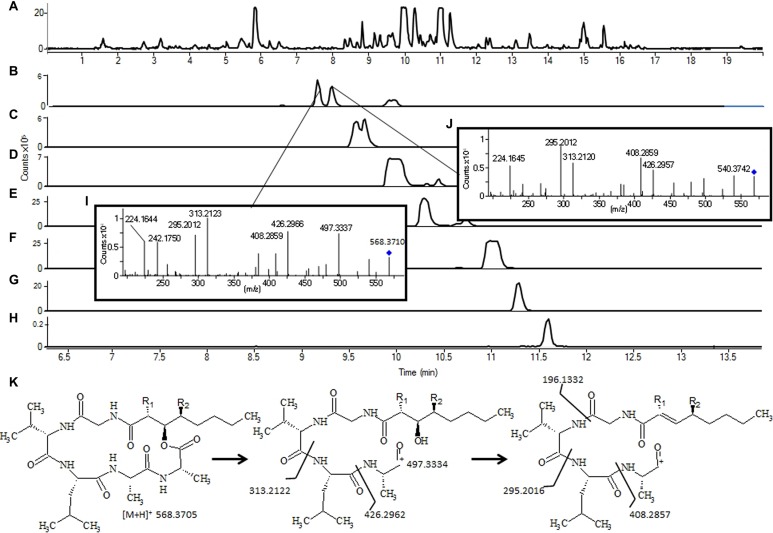
Tentative identification of emericellamides in an extract of Aspergillus nidulans grown for 7 days on yeast extract sucrose agar: (A) Base Peak chromatogram; (B) novel emericellamides where MS/HRMS and retention time suggest the structure shown in (K) with (I) RT 9.17 (R1 = CH3, R2 = H) and (J) RT 9.33 (R1 = H, R2 = CH3). Water loss from the fatty acid chain is more favored when R1 = H as a conjugation with the carbon can occur. (C) shows other novel emericellamides G (R1 = H, R2 = H) presumably with the fatty chain 2 × CH2 longer. (H), emericellamide B; (G), emericellamide H (emericellamide E, with R1 = CH3, R2 = CH3); (F), emericellamide F; (E), emericellamide A; and (D), emericellamide C. For instrument settings see Kildgaard et al. (2014).